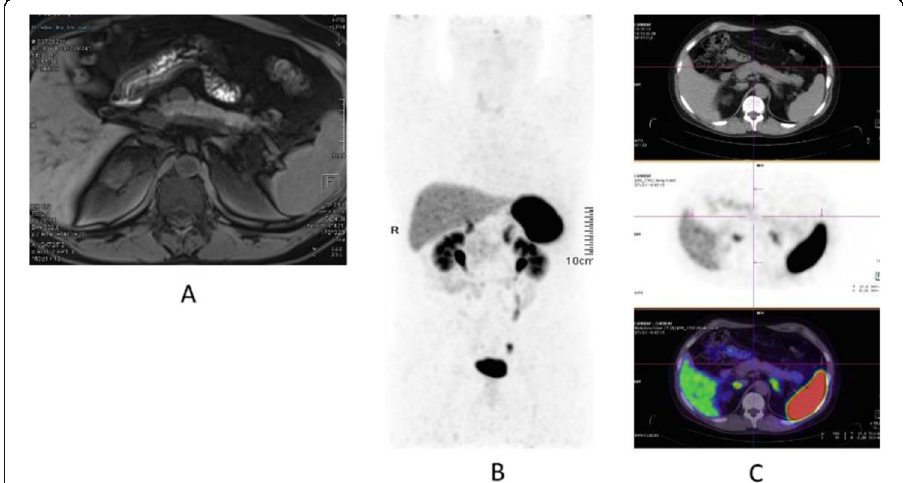
Fig. 49 68 Ga-DOTA peptide, suspected lesion of the pancreas, false negative. Clinical history : 48 y.o. man with lesion in the pancreatic body ( a MRI). Clinical suspicion of insulinoma (hypoglycaemias). PET/CT findings : no uptake in the lesion ( b MIP, c CT, PET, and fused images). The patient underwent surgery, which confirmed the presence of an insulinoma (frequently false negative with 68 Ga-DOTA